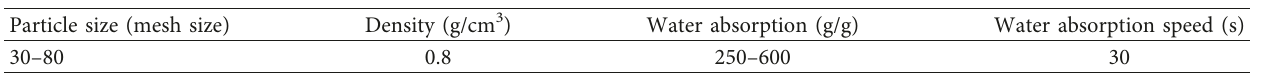
Table 4: Properties of SAP.